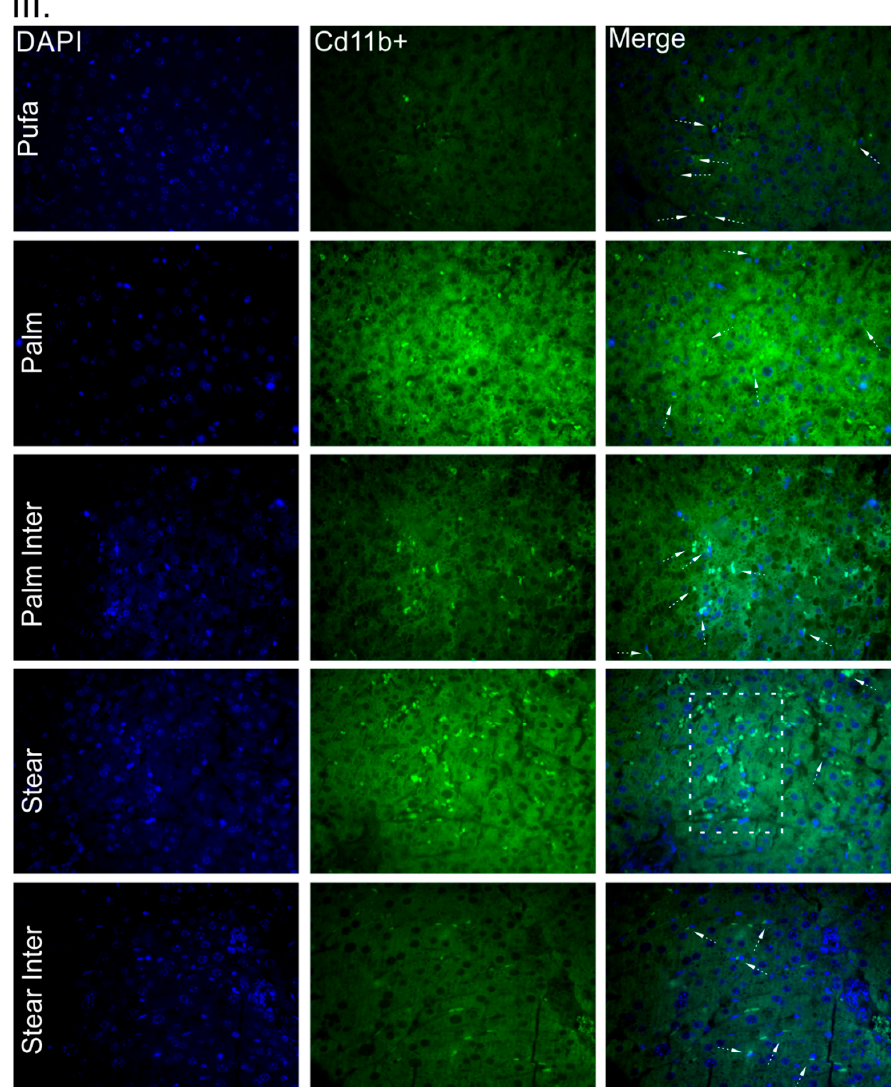
Figure 2. Interesterified fats induce higher collagen content, but STEAR INTER group presents NASH (score = 5). Section I . Photomicrography of hepatic tissue dissected from LDLr-KO mice fed a high-fat diet enriched with polyunsaturated fatty acids (PUFA), palmitic acid (PALM), palmitic interesterified fat (PALM INTER), stearic acid (STEAR), and stearic interesterified fat (STEAR INTER). Sections were stained with Hematoxylin Eosin (HE) for neutrophil content (identified by nuclear and cytoplasmic appearance and counted in 20 fields of the hepatic parenchyma (3.4 mm 2 /blade) and stained with Picrosirius red for collagen content (volume %) and expressed as the percentage of area of the centrilobular vein and portal triad) ( n = 10). Photomicrography of HE and Picrosirius red are under 20× and 40× objective lens, respectively. Liver disease scores: PUFA and STEAR = 2; PALM and PALM INTER = 4; STEAR INTER = 5. M1-like macrophages in the hepatic tissue of LDLr-KO mice. Representative photomicrography. Section II . ( A – I ) Data were checked for normality prior to statistical analysis. One-way ANOVA was performed, followed by the post hoc Newman–Keuls test. Statistically significant difference is presented by different letters ( p < 0.05) with a > b > c values. Data are shown as mean ± SEM ( n = 6). Section III . White arrows or white-segmented board indicating the presence of CD11b+ cells in liver sections from mice fed five of the different fats are presented under 200× magnification.